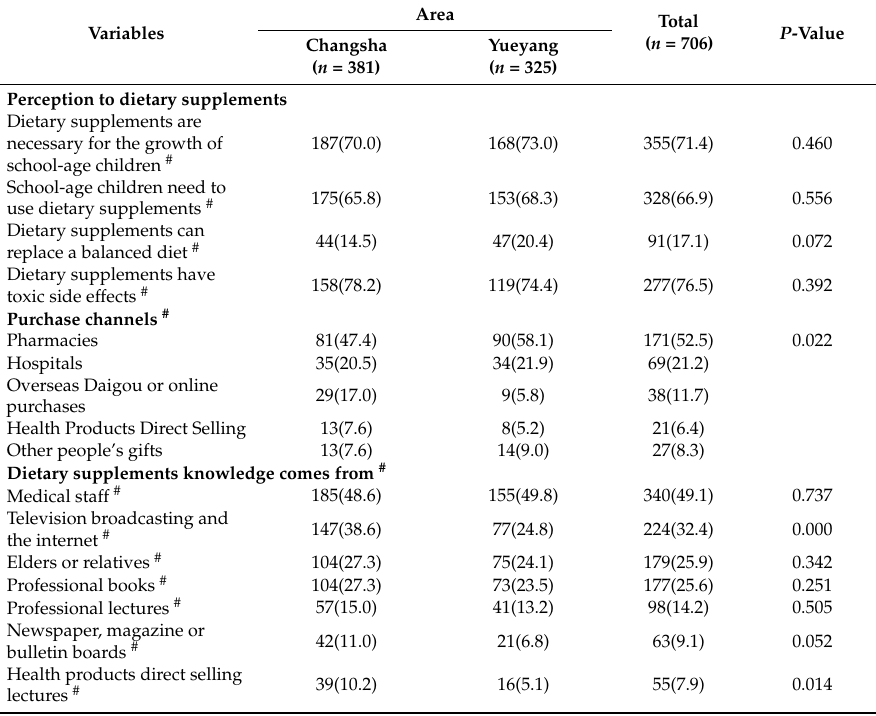
Table 3. Caregivers’ perception and purchase channels of dietary supplements for their